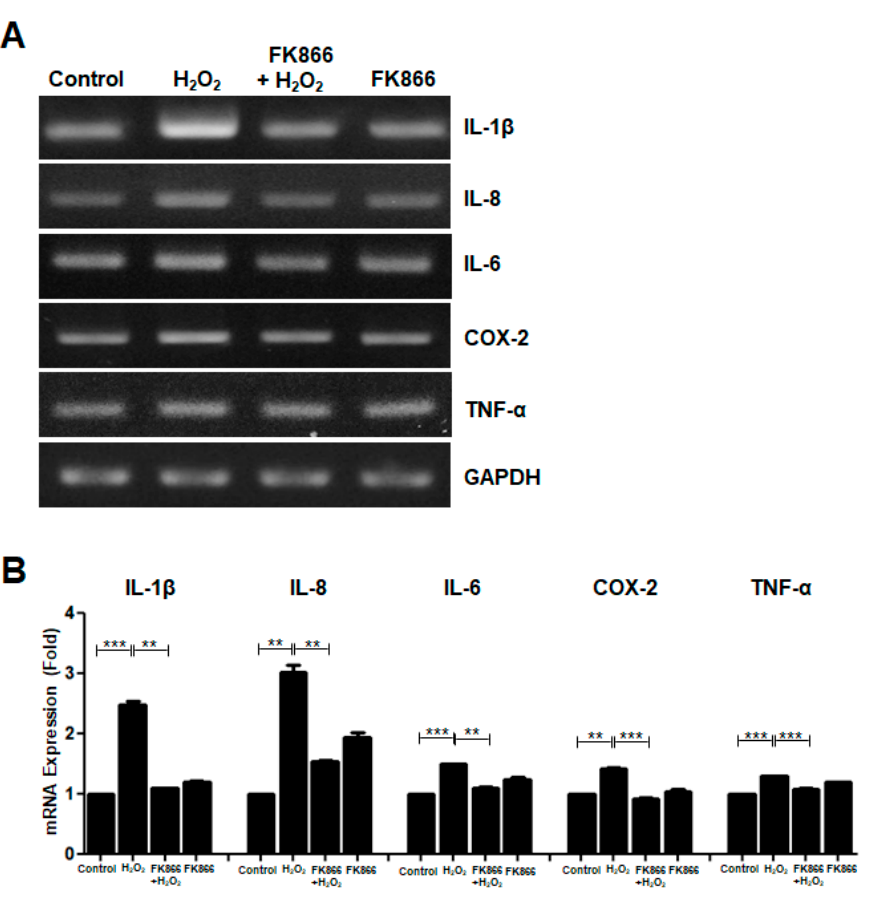
Figure 4. Effect of FK866 on the H 2 O 2 -induced upregulation of SASP factors in hDPCs. The hDPCs were pretreated with FK866 (10 µ M) for 2 h and then stimulated with H 2 O 2 (400 nM) for 24 h. ( A ) The cell lysates were subjected to RT-PCR for determining the mRNA levels of the indicated SASP markers. GAPDH was used as an internal control. ( B ) Densitometric analysis for assessing the relative mRNA expression level of each SASP factor normalized to the mRNA level of GAPDH. ** p < 0.01, *** p < 0.001.